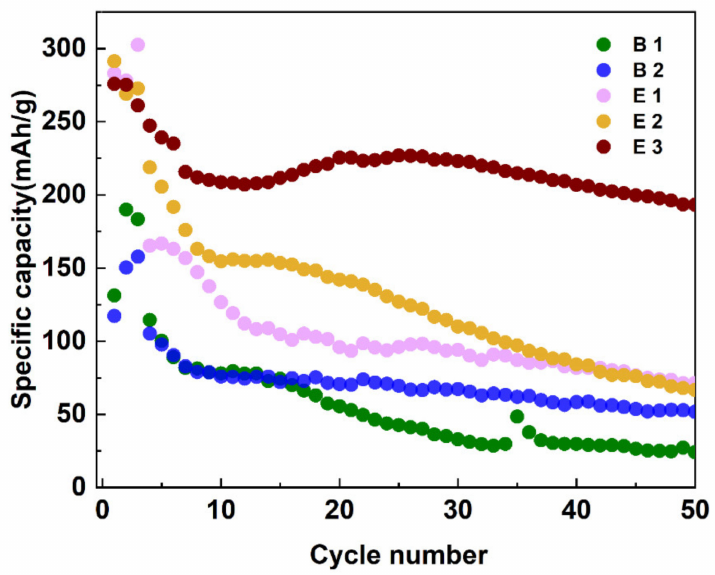
Figure 7. Cycle performances of different electrolytes in C||Li batteries at 0.1 C. The first three cycles were measured at a rate of 0.05 C for